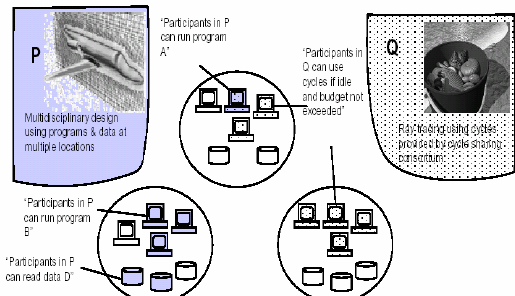
Figure 5: An actual organization can participate in one or more VOs by sharing some or all of its resources .